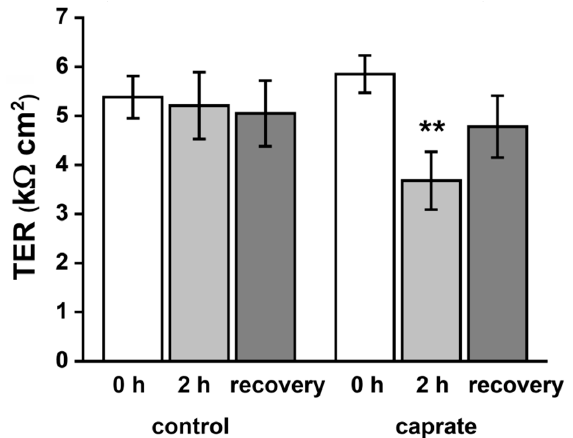
Figure 1. Transepithelial electrical resistance (TER) of IPEC-J2 cell monolayers. Incubation with 5 mM caprate leads to a reversible decrease of TER (** p < 0.01, n =